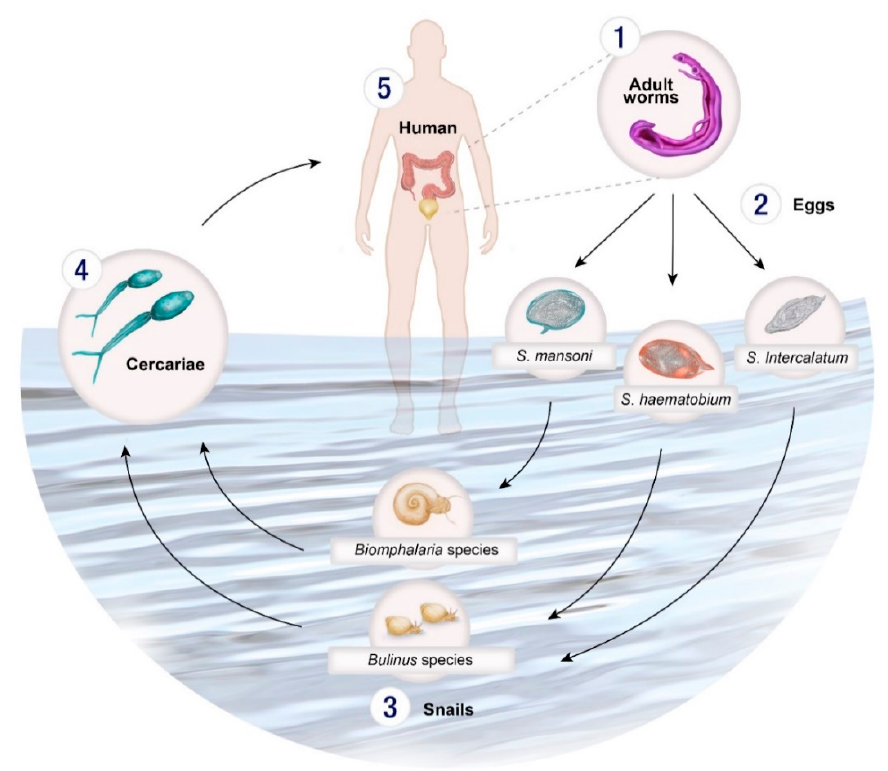
Figure 1. Life cycle of Schistosoma spp. (1) Male and female adult worms reproduce sexually in the venous system of the bladder ( S. haematobium ) or the bowel ( S. mansoni, S. intercalatum, S. guineensis ) producing eggs which are excreted in urine or via faeces, or are retained in body tissues, such as the liver. (2) The eggs hatch upon contact with water releasing mira ‐ cidia which then penetrate a specific intermediate molluscan host. (3) Within the snail host, the miracidia develop into sporocysts and asexually reproduce daughter sporocysts which in turn produce cercariae. (4) The cercariae emerge from the snail and directly penetrate the skin of the (5) human host and transform into schistosomula. The schistosomula mi ‐ grate via the circulatory system to the lungs and then the heart before arriving in the liver where they mature. Once mature the adult worms exit the liver and pair up to mate in the mesenteric vessels of the bowel bowel ( S. mansoni, S. intercalatum, S. guineensis ) or bladder ( S. haematobium